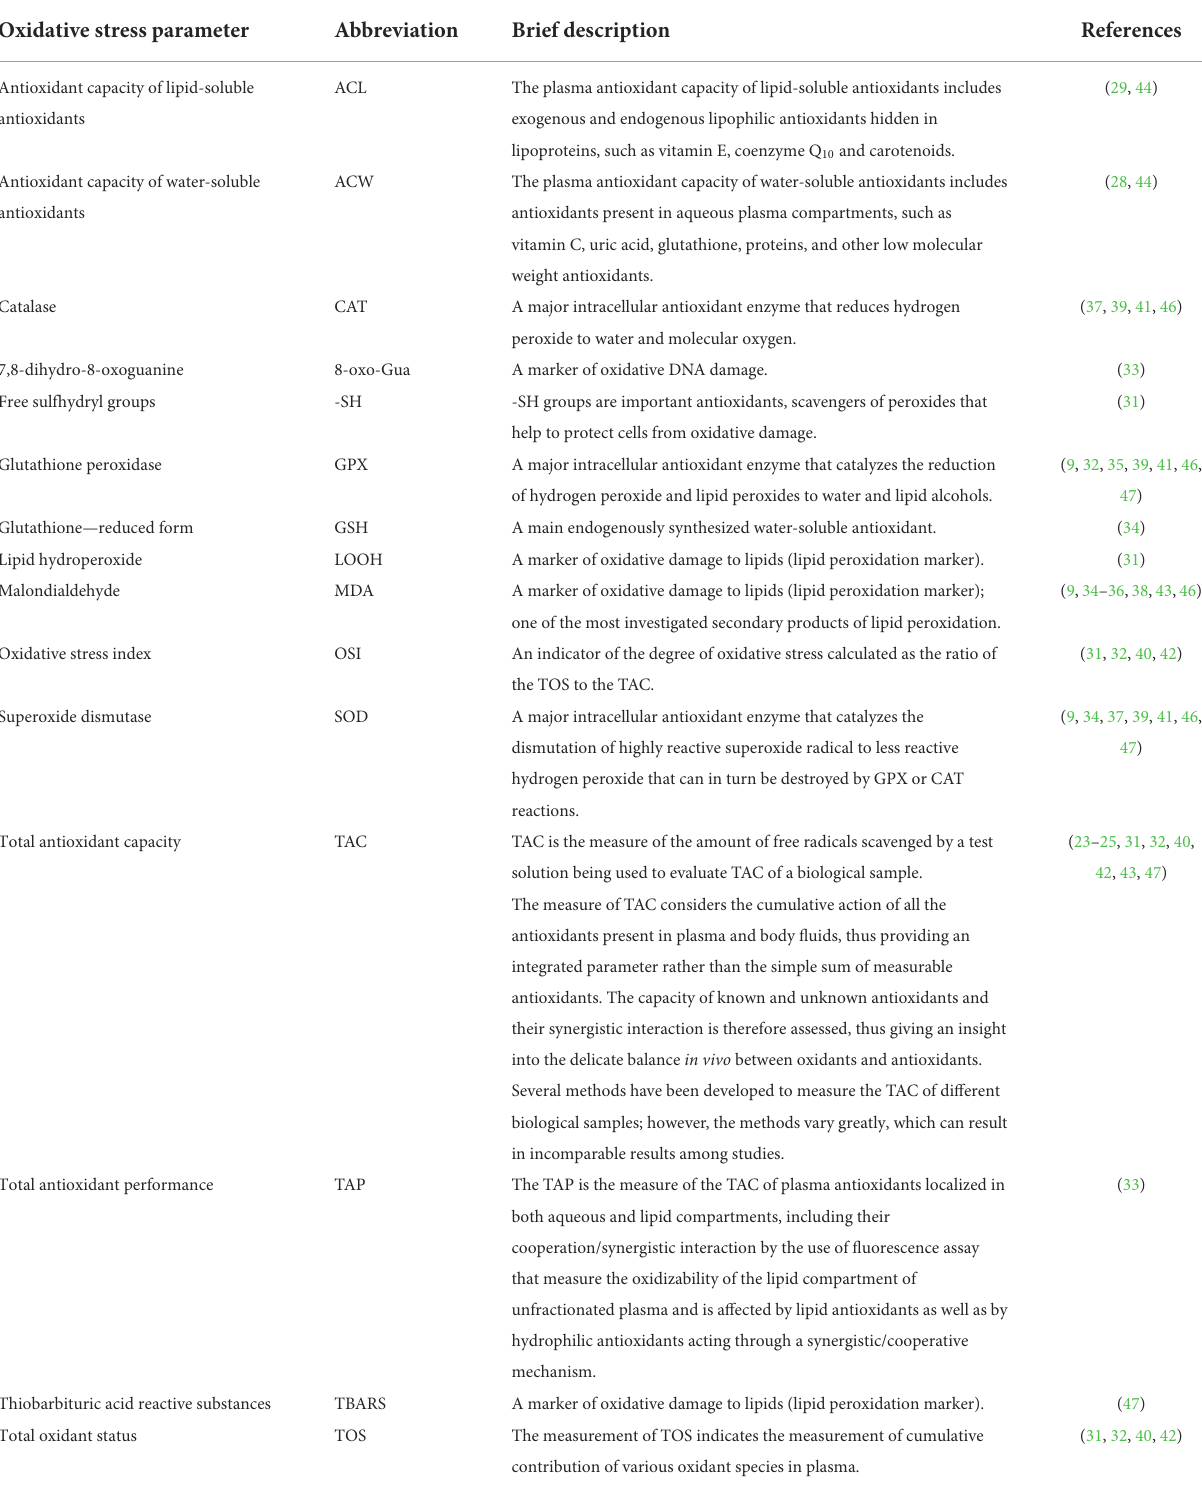
TABLE 2 Brief presentation of the oxidative stress parameters mentioned in the